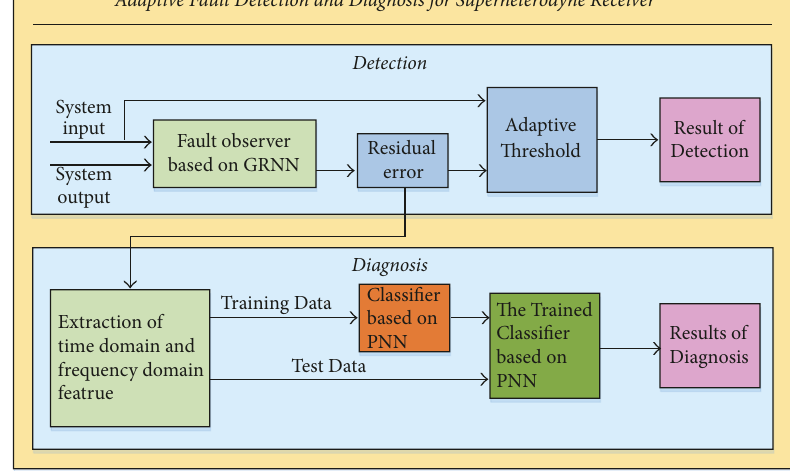
Figure 2: The adaptive fault detection and diagnosis for the superheterodyne receiver.